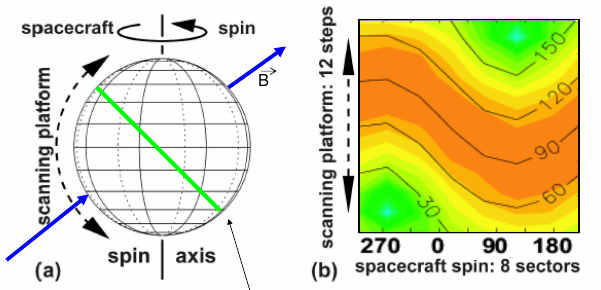
Fig. 3. This figure shows how to interpret Fig. 4-7. The entire unit sphere (left) is scanned through every 36 seconds and the fluxes are linearly translated onto the orthogonal Cartesian coordinate sphere (right). The blue arrow (left) indicates the direction of the magnetic field vector and the green line (left) is the location of 90 ◦ PA particles (from Whitaker et al., 2007).